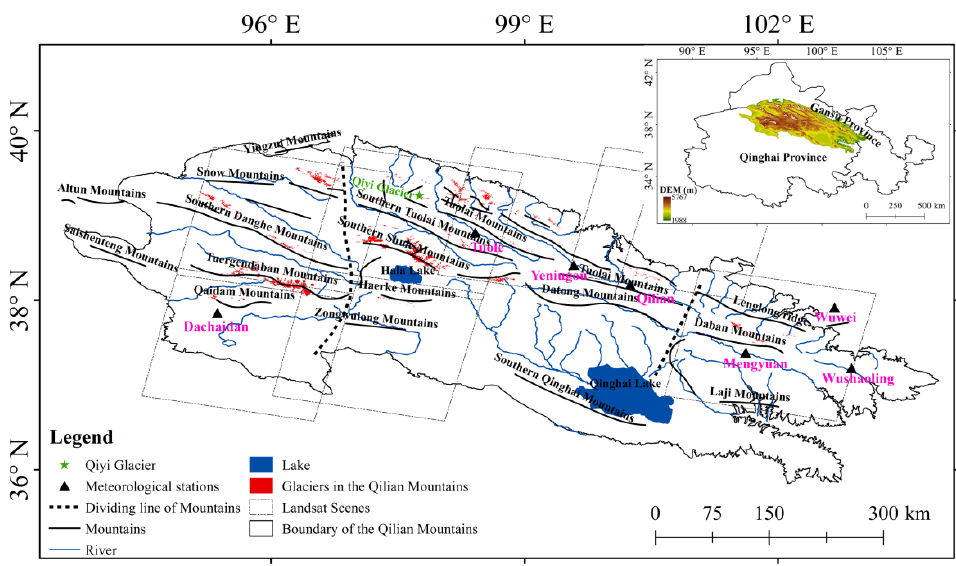
Figure 1. Location of the study area in the Qilian Mountains, with the glaciers and meteorological stations